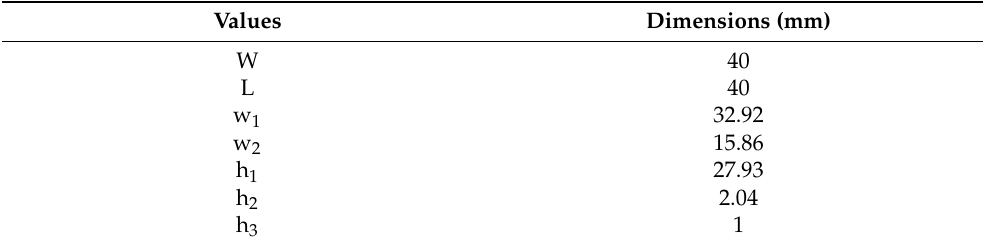
Table 1. Size of the antenna tuned to f = 3.5